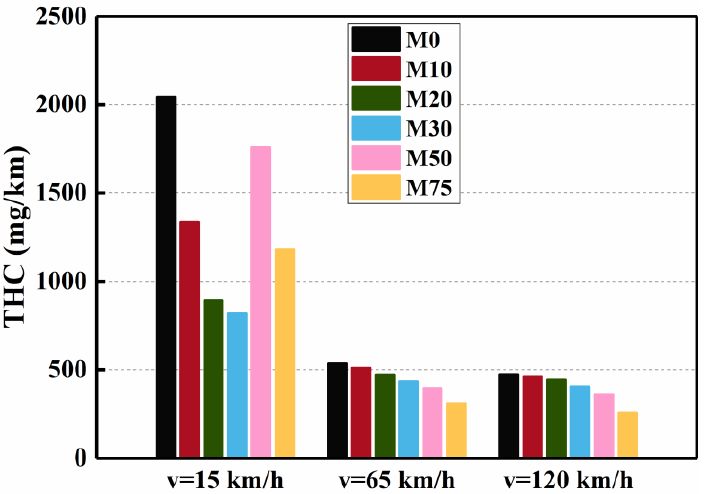
Figure 7. Effects of different methanol blending ratios on THC emissions at different vehicle speeds.